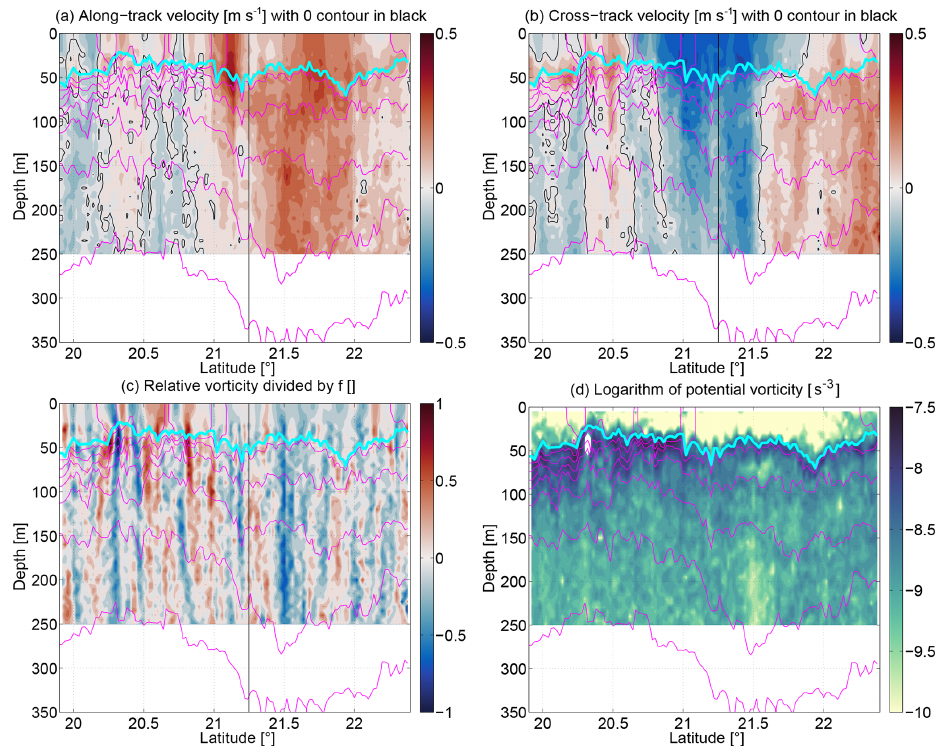
Figure 6. Sections of (a) along-track velocity (in meters per second; positive, roughly northward), (b) cross-track velocity (in meters per second; positive, roughly eastward), (c) Rossby number (relative vorticity divided by f ), and (d) logarithm of potential vorticity (in per second cubed). The vertical black line at 21.25 ◦ N highlights where the course of the section turned by 4 ◦ from 10.5 to 14.5 ◦ with respect to true